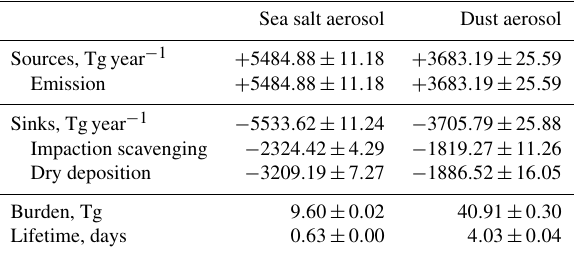
Table 4. Global mass budgets and lifetimes of total sea salt aerosol and total dust aerosol for the year-2000 MARC simulation, summed across the four dust aerosol modes and four sea salt aerosol modes. The processes acting as sources and sinks are summarised in Fig. 1d and e. Corresponding results for the year-1850 MARC simulation are shown in Table